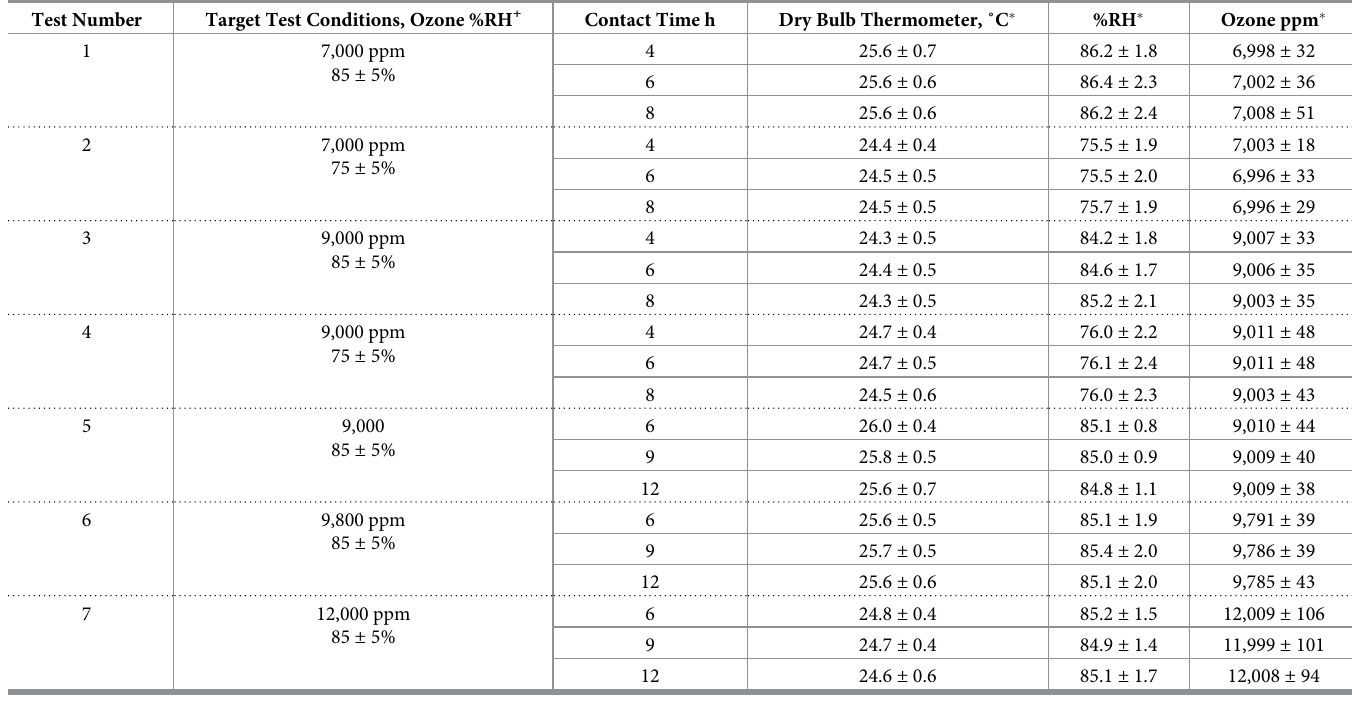
Table 4. Summary of actual temperature, relative humidity and ozone conditions for B . subtilis tests.